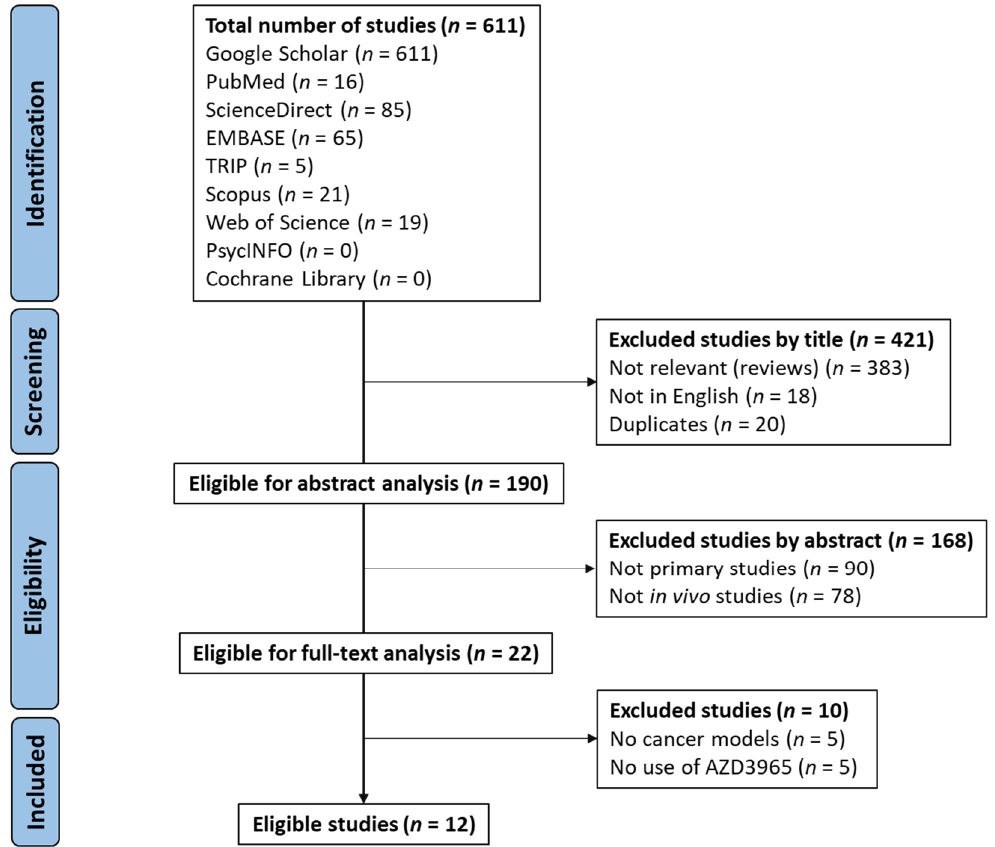
Figure 3. PRISMA 2020 flow diagram (adapted from [34]).